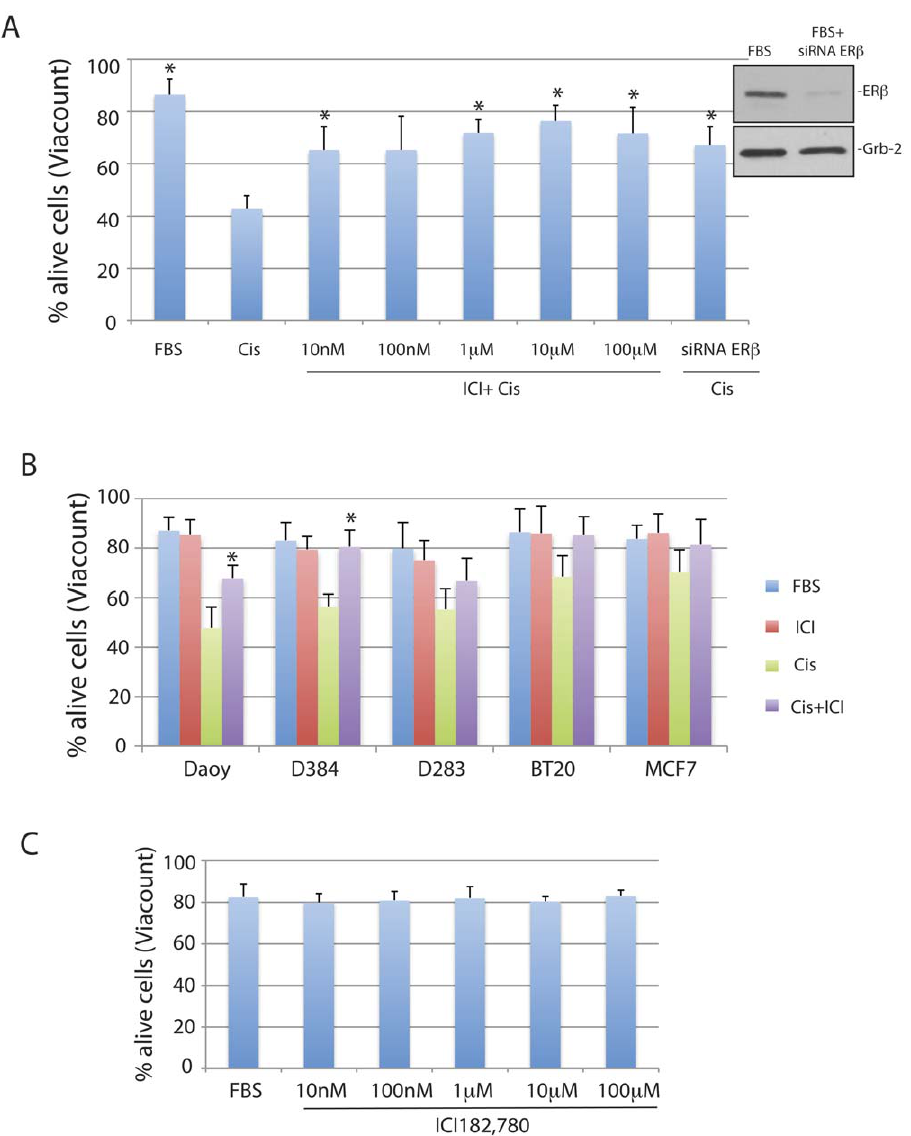
Figure 2. ICI182,780 dose response and tumor cell survival. Panel A: Evaluation of cell viability (ViaCount) of exponentially growing Daoy cells (FBS) treated with cisplatain (Cis; 1 m g/ml for 48 hrs) in the presence or absence of ER b antagonist, ICI182,780 at indicated concentrations. In one instance the cells were preincubated for 48 hrs with siRNA against ER b mRNA (siRNA ER b ; 200 nM). Inset: Western blot showing effectiveness of ER b siRNA (200 nM for 48 hrs) tested in exponentially growing Daoy cells. Data represent average values from 3 experiments in triplicate (n=9) with standard deviation. *indicate values significantly different from Cis (paired student t-test P # 0.05). Panel B: Evaluation of cell viability (ViaCount) in three medulloblastoma (Daoy, D283Med and D384Med) and two breast cancer (MCF7 and BT-20) cell lines. The cells were cultured in 10%FBS (FBS); 10%FBS + ICI182,780 (10 m M) (ICI); 10%FBS + Cisplatin (1 m g/ml) (Cis); and 10%FBS + ICI182,780 (10 m M) + Cisplatin (1 m g/ml) (Cis + ICI) for 48 hrs. Data represent average values from 2 experiments in triplicate (n=6) with standard deviation. *indicate values significantly different from Cis